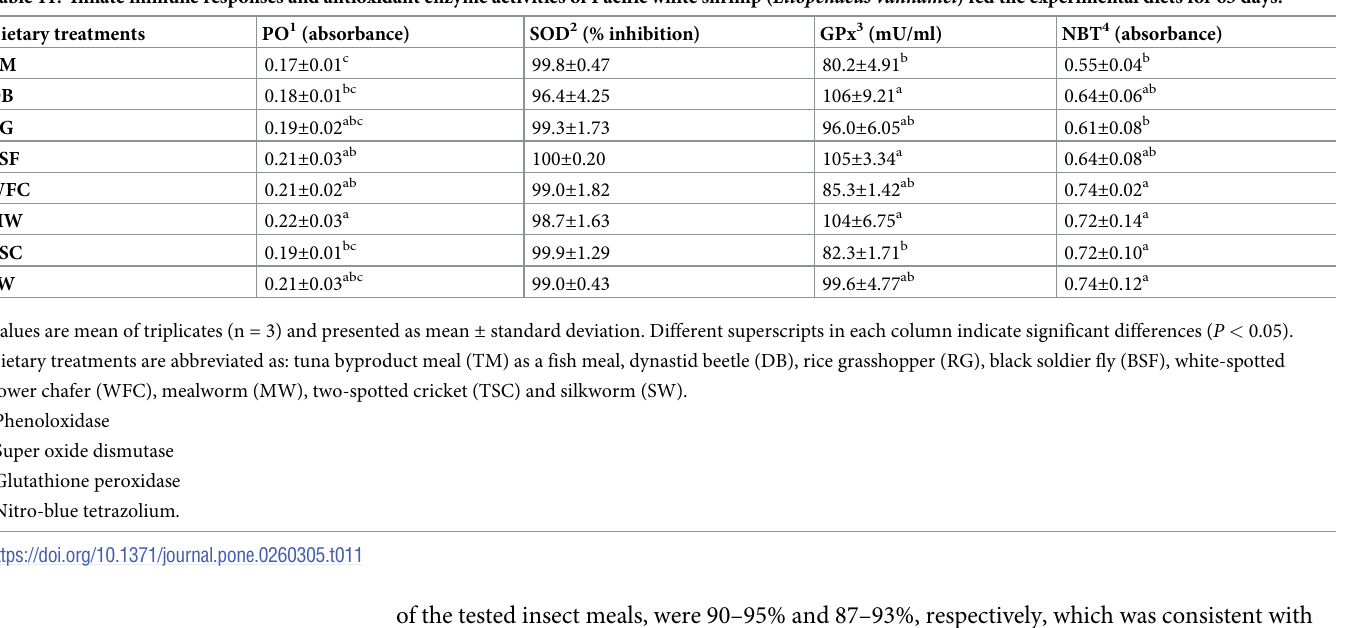
Table 11. Innate immune responses and antioxidant enzyme activities of Pacific white shrimp ( Litopenaeus vannamei ) fed the experimental diets for 65 days. Dietary treatments